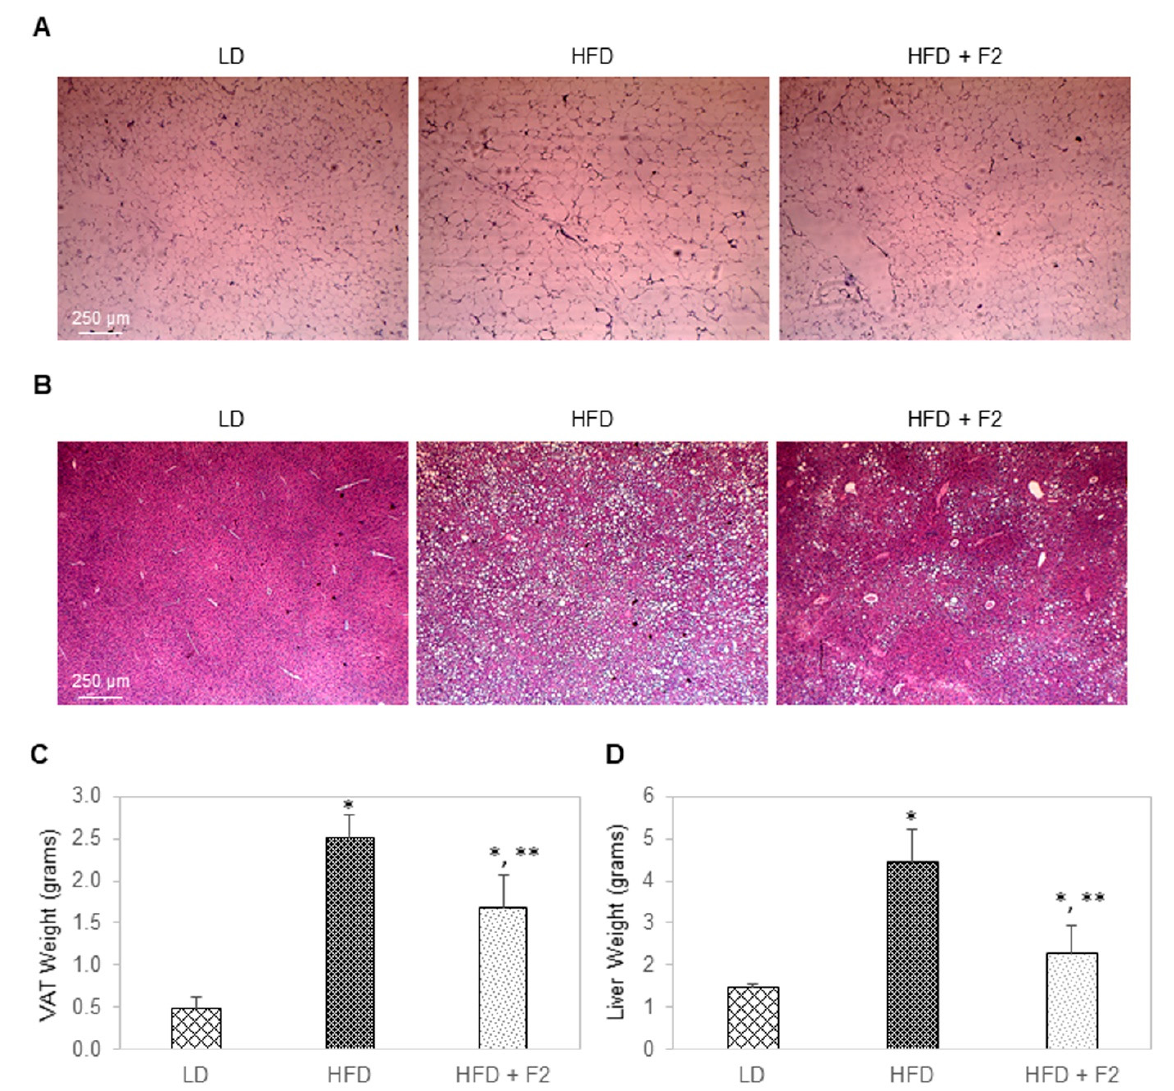
Figure 8. F2 composition reduces visceral adiposity and liver steatosis in diet-induced obesity mice. H&E histology of ( A ) visceral adipose tissues and ( B ) liver tissues collected from three animal groups on specified diets. ( C ) Visceral adipose tissue weight and ( D ) liver tissue weight as a function of animal groups on specified diets. LD: Lean diet; HFD: High-fat diet; HFD + F2: High-fat diet supplemented with F2. Visceral adipose tissues and liver tissues were terminally collected after 17 weeks on specified diets. The error bars indicate the standard deviations of 40 mice per animal group. Single asterisk (*) indicates a statistical significance of p -value ≤ 0.01 versus the lean diet group. Double asterisk (**) indicates a statistical significance of p -value ≤ 0.01 versus the high-fat diet group.